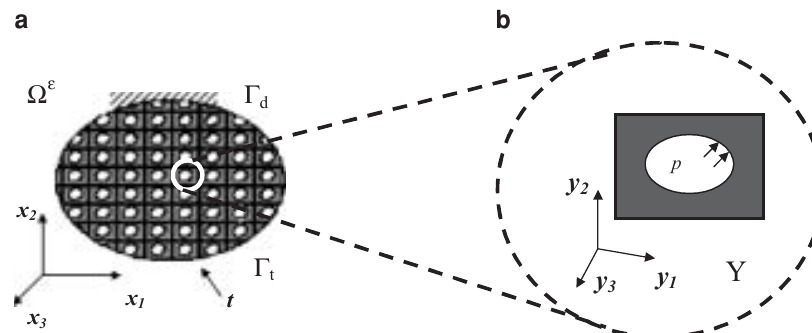
Figure 1 Heterogeneous body (a) and its periodic unit cell (RVE)